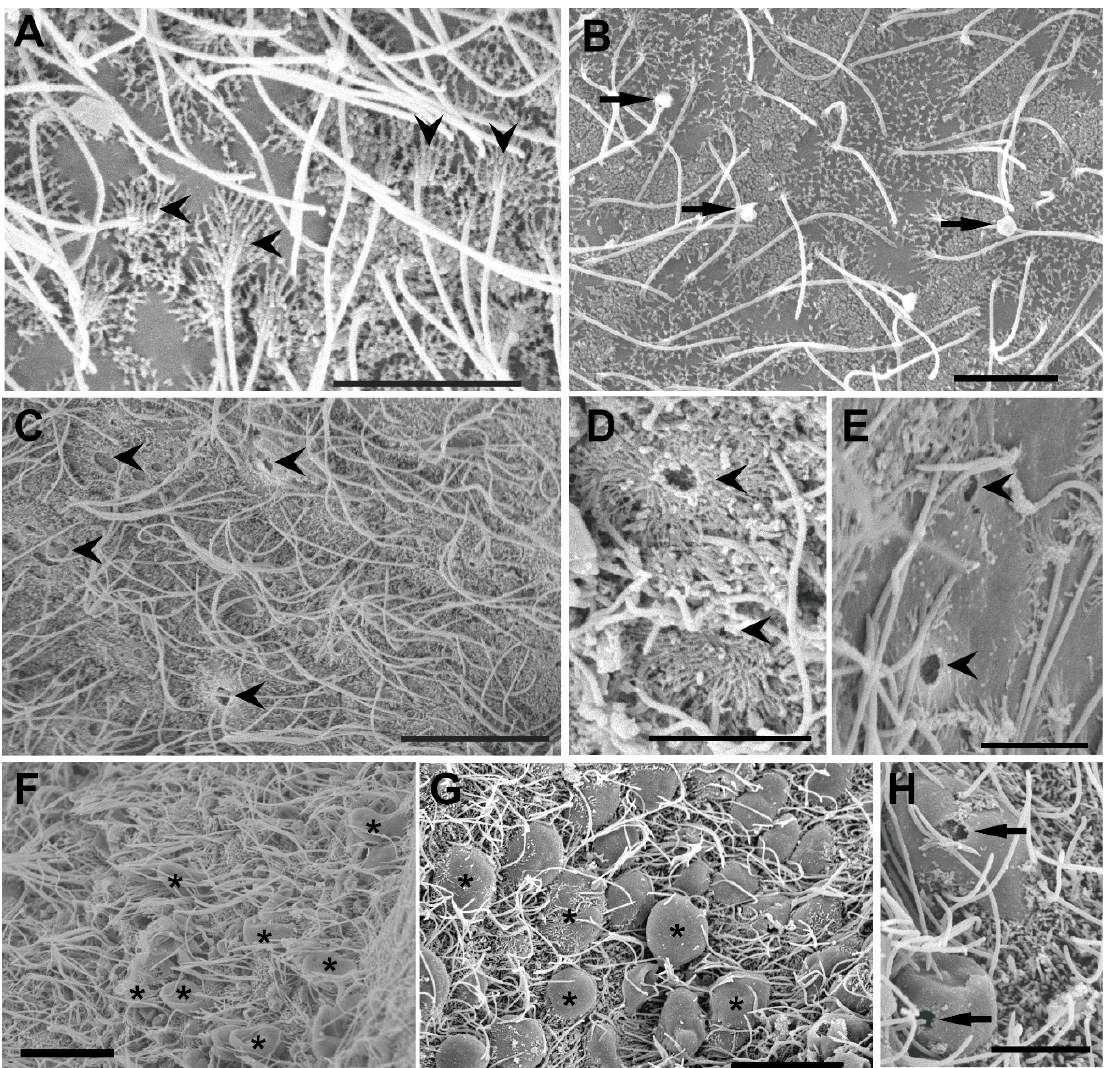
Figure 6. SEM. P. maculata statocyst sensory epithelium. ( A ): Control animal. ( B – D ): 48 h after sound exposure. ( F – H ): 120 h after sound exposure. ( A ): Healthy hair cells show the kinocilia surrounded by a crown of stereocilia (arrowheads). ( B ): Some hair cells present swollen kinocilia (arrows). ( C ): Arrowheads point to the holes left by the single kinocilia after their ejection. ( D ): Detail from ( C ). Surrounding the hole left by the ejected kinocilia a crown of stereocilia are fused in a compact structure. ( E ): Detail from ( C ). The hair cells have lost the entire kinocilia and the crown of stereocilia (arrowheads). ( F ): The hair cells show severe damage. Most hair cells are (asterisks) ejected from the sensory epithelium. ( G ): Detail from ( F ), shows the cellular body of the sensory cells extruded from the epithelium (asterisks). ( H ): Two extruded hair cells show spherical holes in the body due to the extrusion of the inner cellular material (arrows). Their kinocilia has lost the stereocilia crown. Scale bar: ( A , B , D , E , H ) = 5 μ m. ( C , G ) = 10 μ m. ( F ) = 20 μ m.